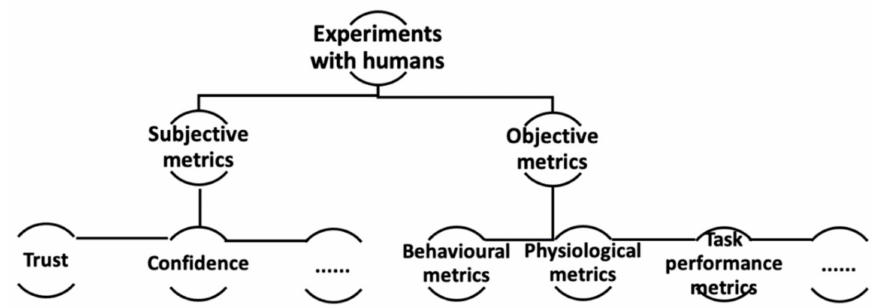
Figure 4. Metrics of human-centred